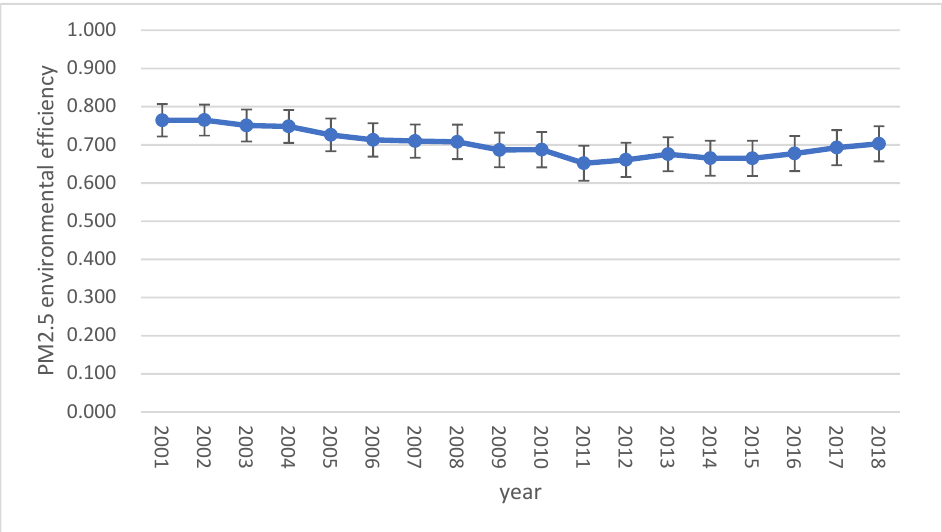
Figure 1. Trend in PM2.5 environmental efficiency in China (2001–2018).